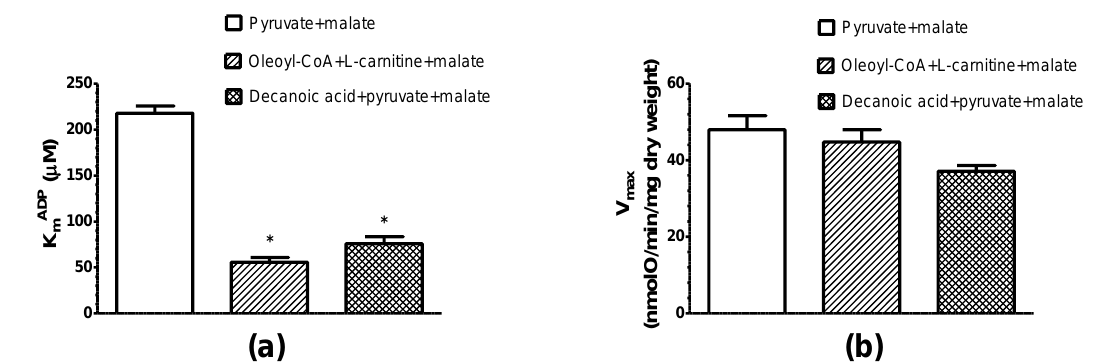
Figure 2. Influence of different respiratory substrates: pyruvate + malate (6 mM + 6 mM), oleoyl-CoA + L -carnitine+malate (6 µM + 2.5mM + 0.24mM) and decanoic acid + pyruvate + malate (0.3 mM + 6 mM + 6 mM) on the apparent K mADP ( a ) and V max ( b ) of saponin-permeabilized rat cardiac fibers. n = 5; 37 ◦ C; * p < 0.05 vs. control (pyruvate + malate). The results were analyzed with one-way analysis of variance (ANOVA) followed by the Dunnett post hoc test.